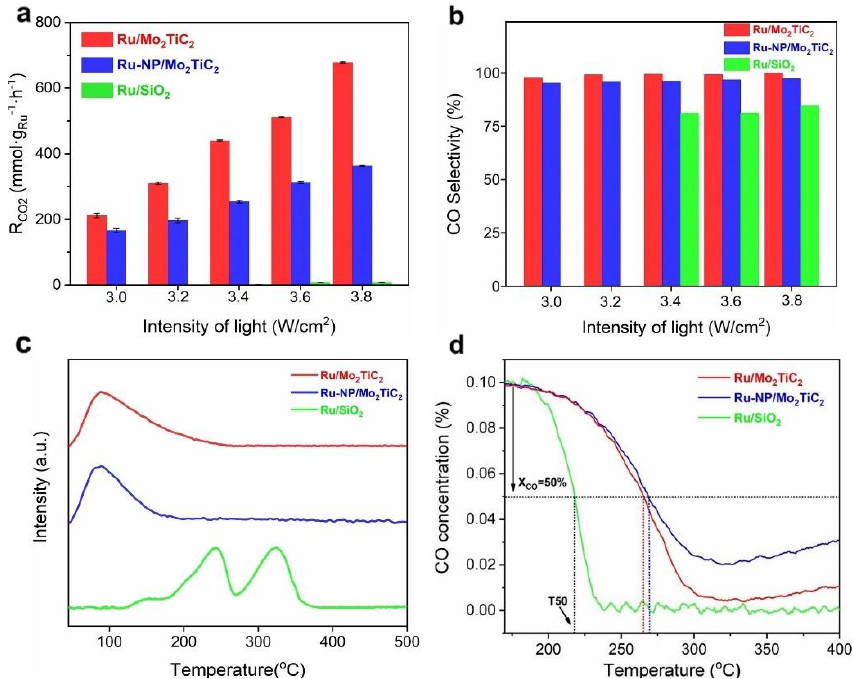
Figure 9. Photothermal catalytic performance and reaction mechanism of Ru/Mo 2 TiC 2 . ( a , b ) Photo- thermal catalytic activity and CO selectivity of Ru/Mo 2 TiC 2 , Ru − NP/Mo 2 TiC 2 , and Ru/SiO 2 under different illumination conditions; ( c ) H 2 − TPD profiles of Ru/Mo 2 TiC 2 , Ru − NP/Mo 2 TiC 2 and Ru/SiO 2 catalysts; ( d ) CO signal of H 2 − assisted CO hydrogenation TPSR for Ru/Mo 2 TiC 2 , Ru − NP/Mo 2 TiC 2 and Ru/SiO 2 catalysts. (Reprinted with permission from Ref. [82], Copyright 2023 American Chem- ical Society).